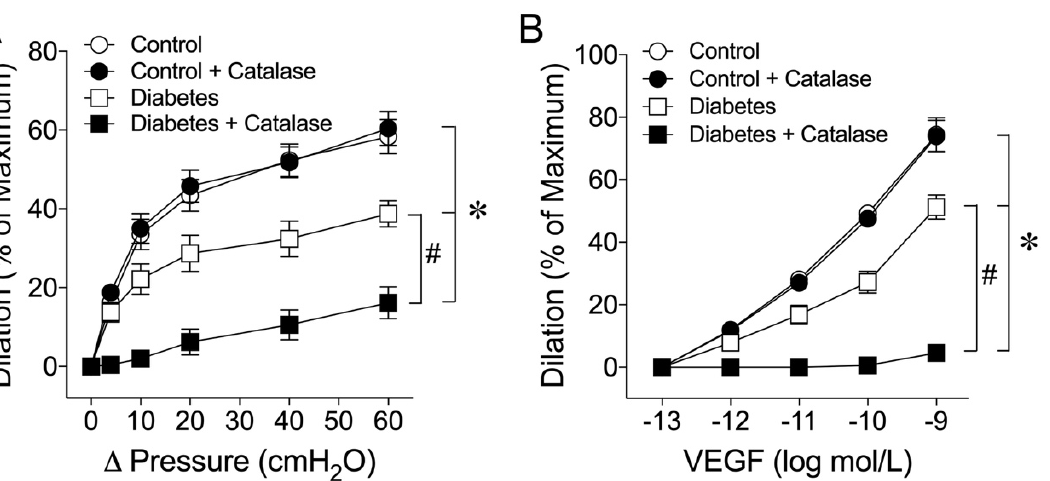
(Figure 3A). Coronary arterioles also dilated in response to H 2 O 2 in a similar manner in both the control and diabetic vessels, and this vasodilation was abolished by catalase (1000 units/mL), except for the highest concentration of H 2 O 2 (Figure 3B).